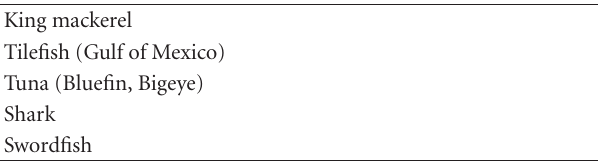
Table 1: Fish with highest MeHg Contamination. King mackerel Tilefish (Gulf of Mexico) Tuna (Bluefin, Bigeye) Shark